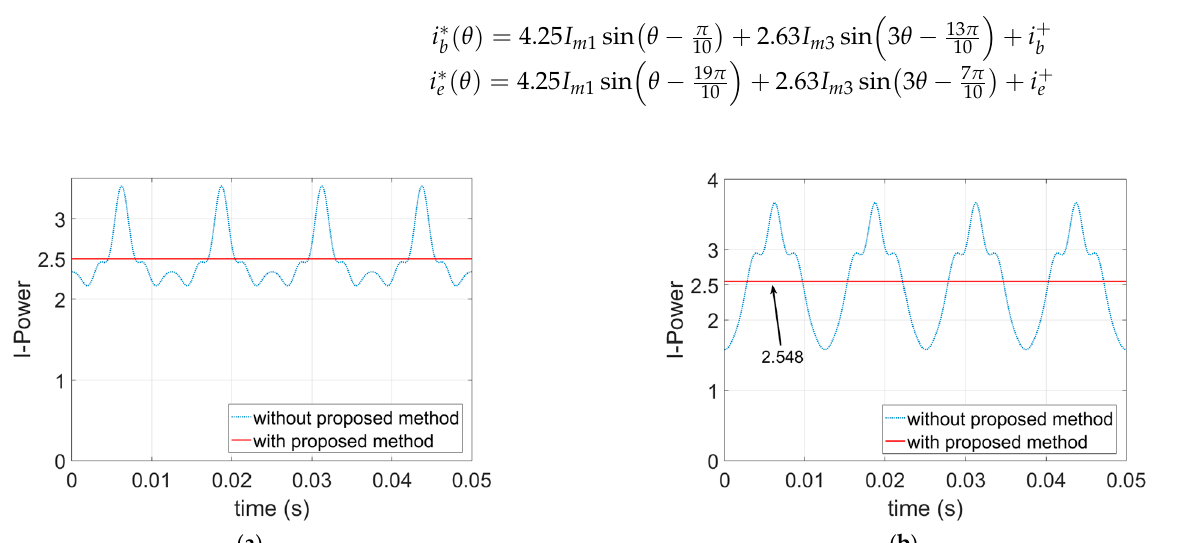
Figure 8. I-power graphs for the nonadjacent three-phase OCFT condition currents: ( a ) Fundamental; ( b ) fundamental plus third harmonic.